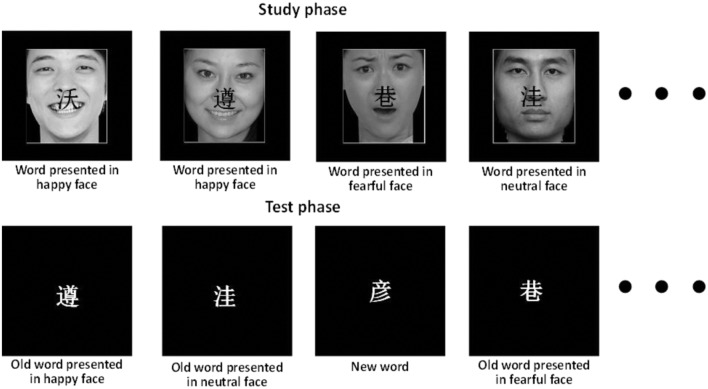
Experimental stimulus sample.